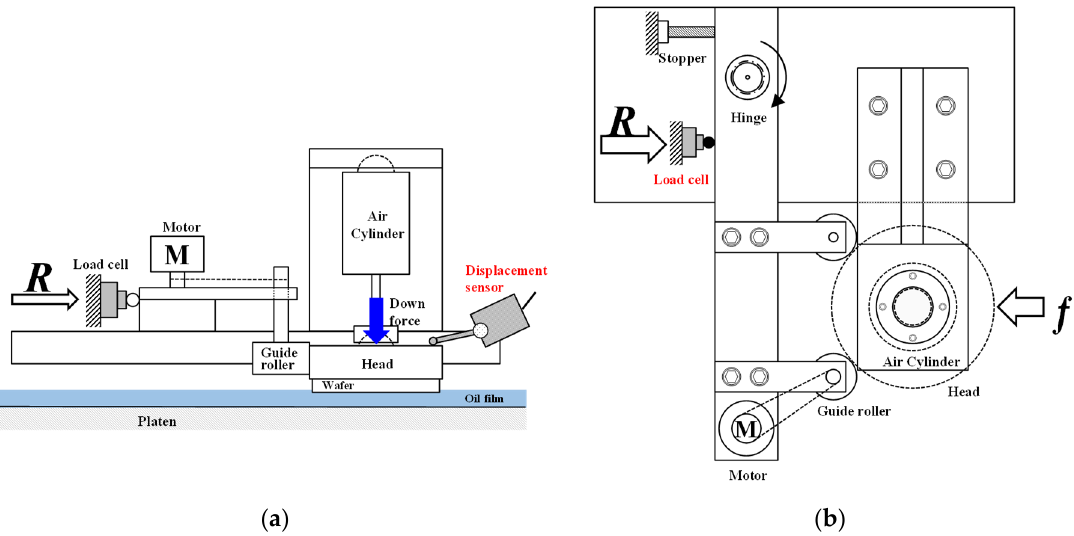
Figure 7. Measuring method: ( a ) oil film thickness and ( b ) frictional force.